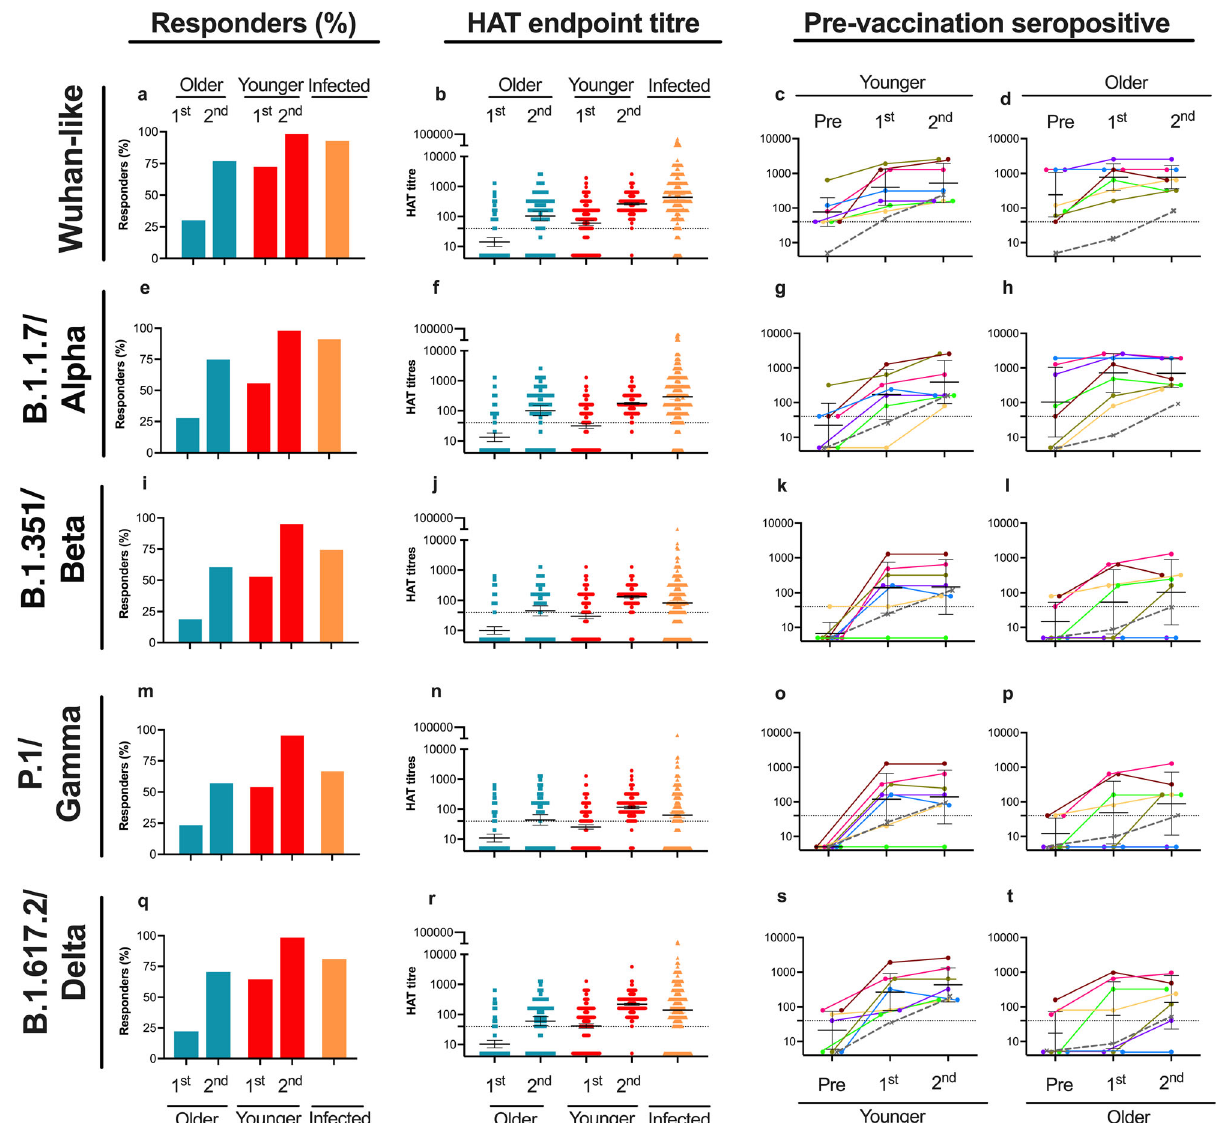
Fig. 2 Haemagglutination test antibodies to the ancestral Wuhan SARS-CoV-2 virus and variants of concern in older and younger adult vaccinees and after natural infection. Haemagglutination test (HAT) antibodies to the SARS-CoV-2 virus receptor binding domains of homologous founder virus ( a – d : Wuhan-like) and variants of concern ( e – h B.1.1.7 alpha; i – l : B.1.351 beta; m – p : P.1 gamma and q – t : B.1.617.2 delta). Endpoint HAT titres are presented